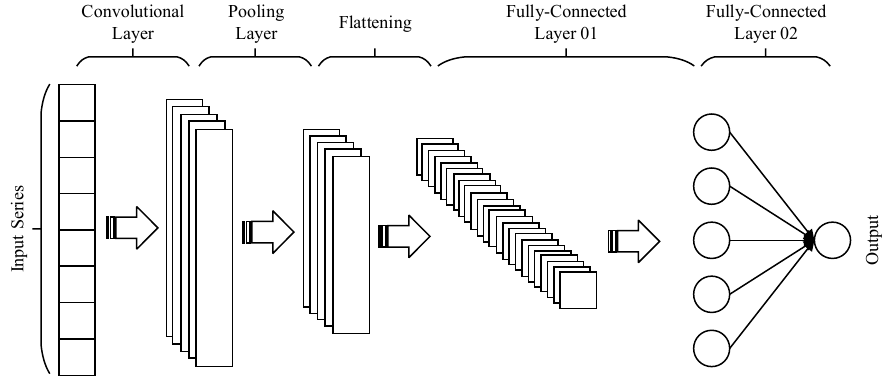
Figure 3. The description of 1D-CNN Network.